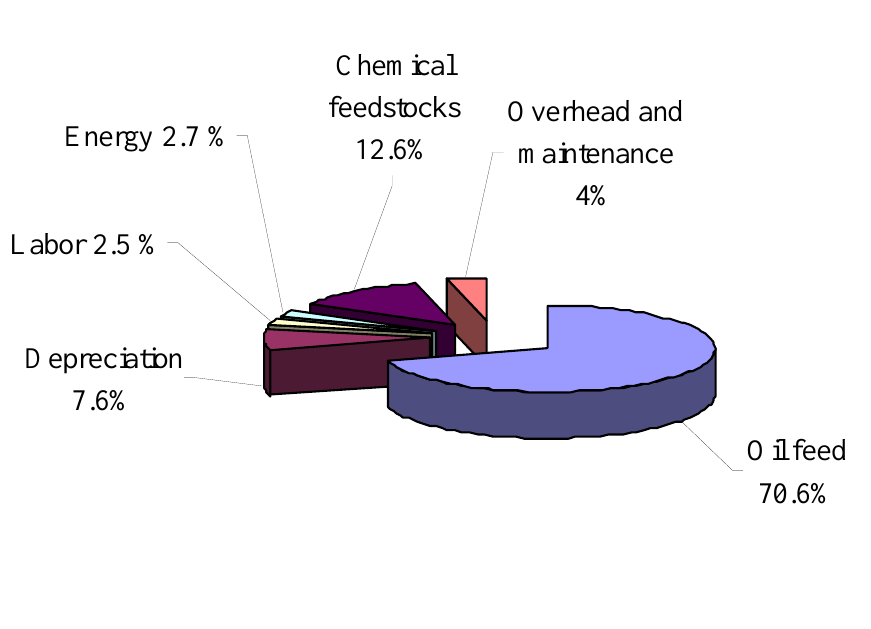
Figure 4. Distribution of biodiesel production costs, % [15]